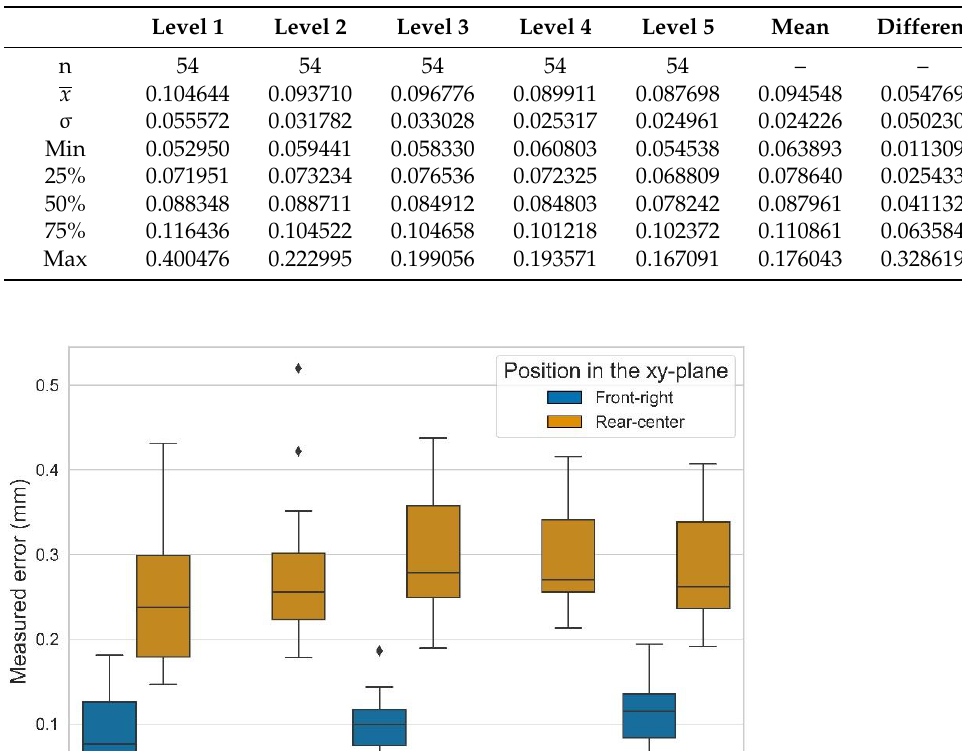
Figure 23. Boxplot for diametrical error for the anchor specimens across all three builds.